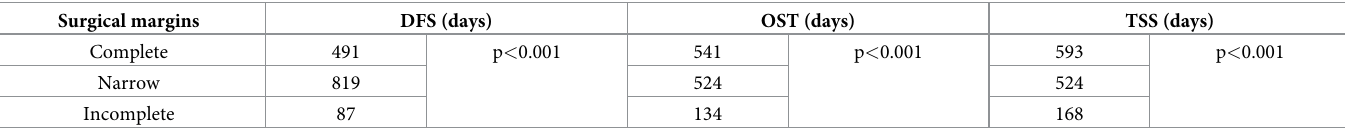
Table 8. Outcome parameters for dogs with lung adenocarcinoma based on surgical margin status. Surgical